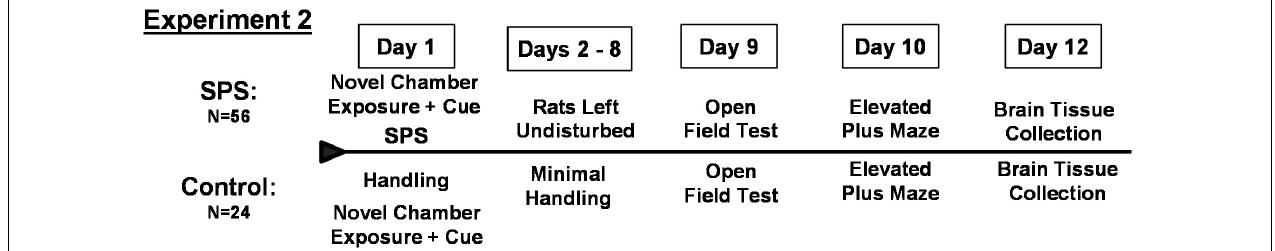
FIGURE 2 | Timeline for Experiment